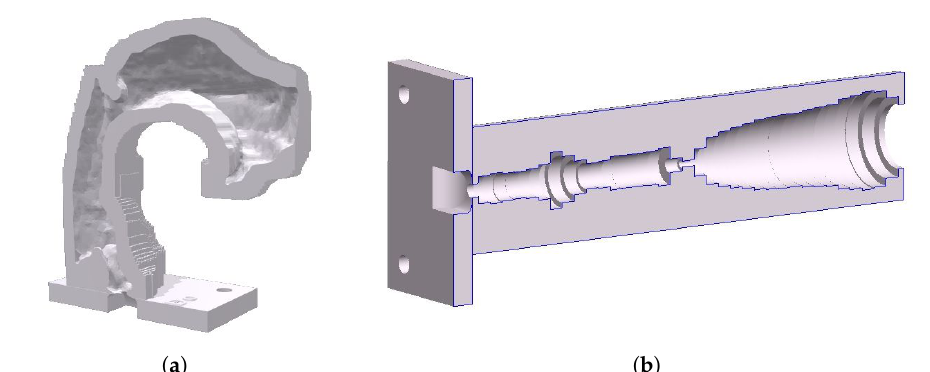
Figure 3. Cut through the 3D replica of ( a ) a realistic VT and ( b ) a simplified